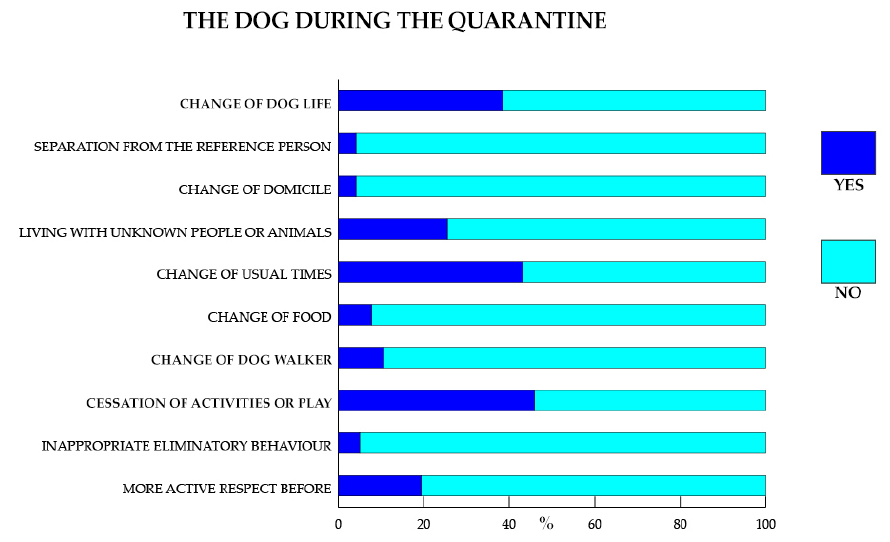
Figure 3. ( A ) Differences in the “Owner-dog interaction and love” factor between the two time of the study. ( B ) Differences in the “Perceived cost” factor between the two times of the study. Time 1 is before the quarantine period; Time 2 is during the quarantine period.